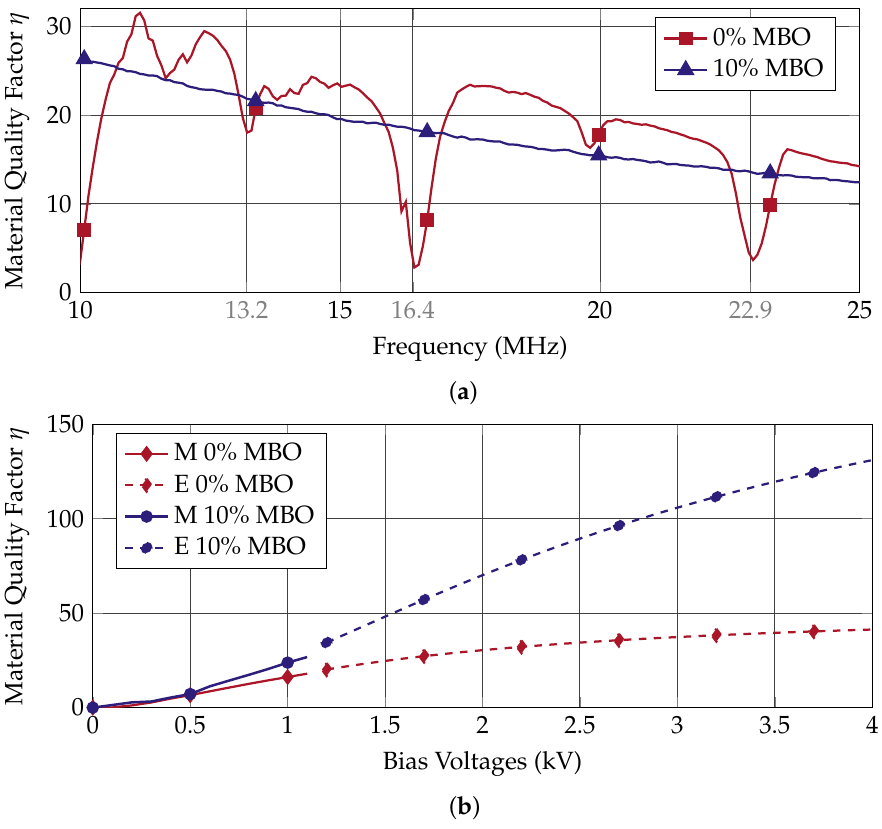
Figure 9. Material quality factor ( η ): ( a ) extracted from measurements at 1.1kV ( b ) extracted from measurements (M) and extracted from Chase model (E) at